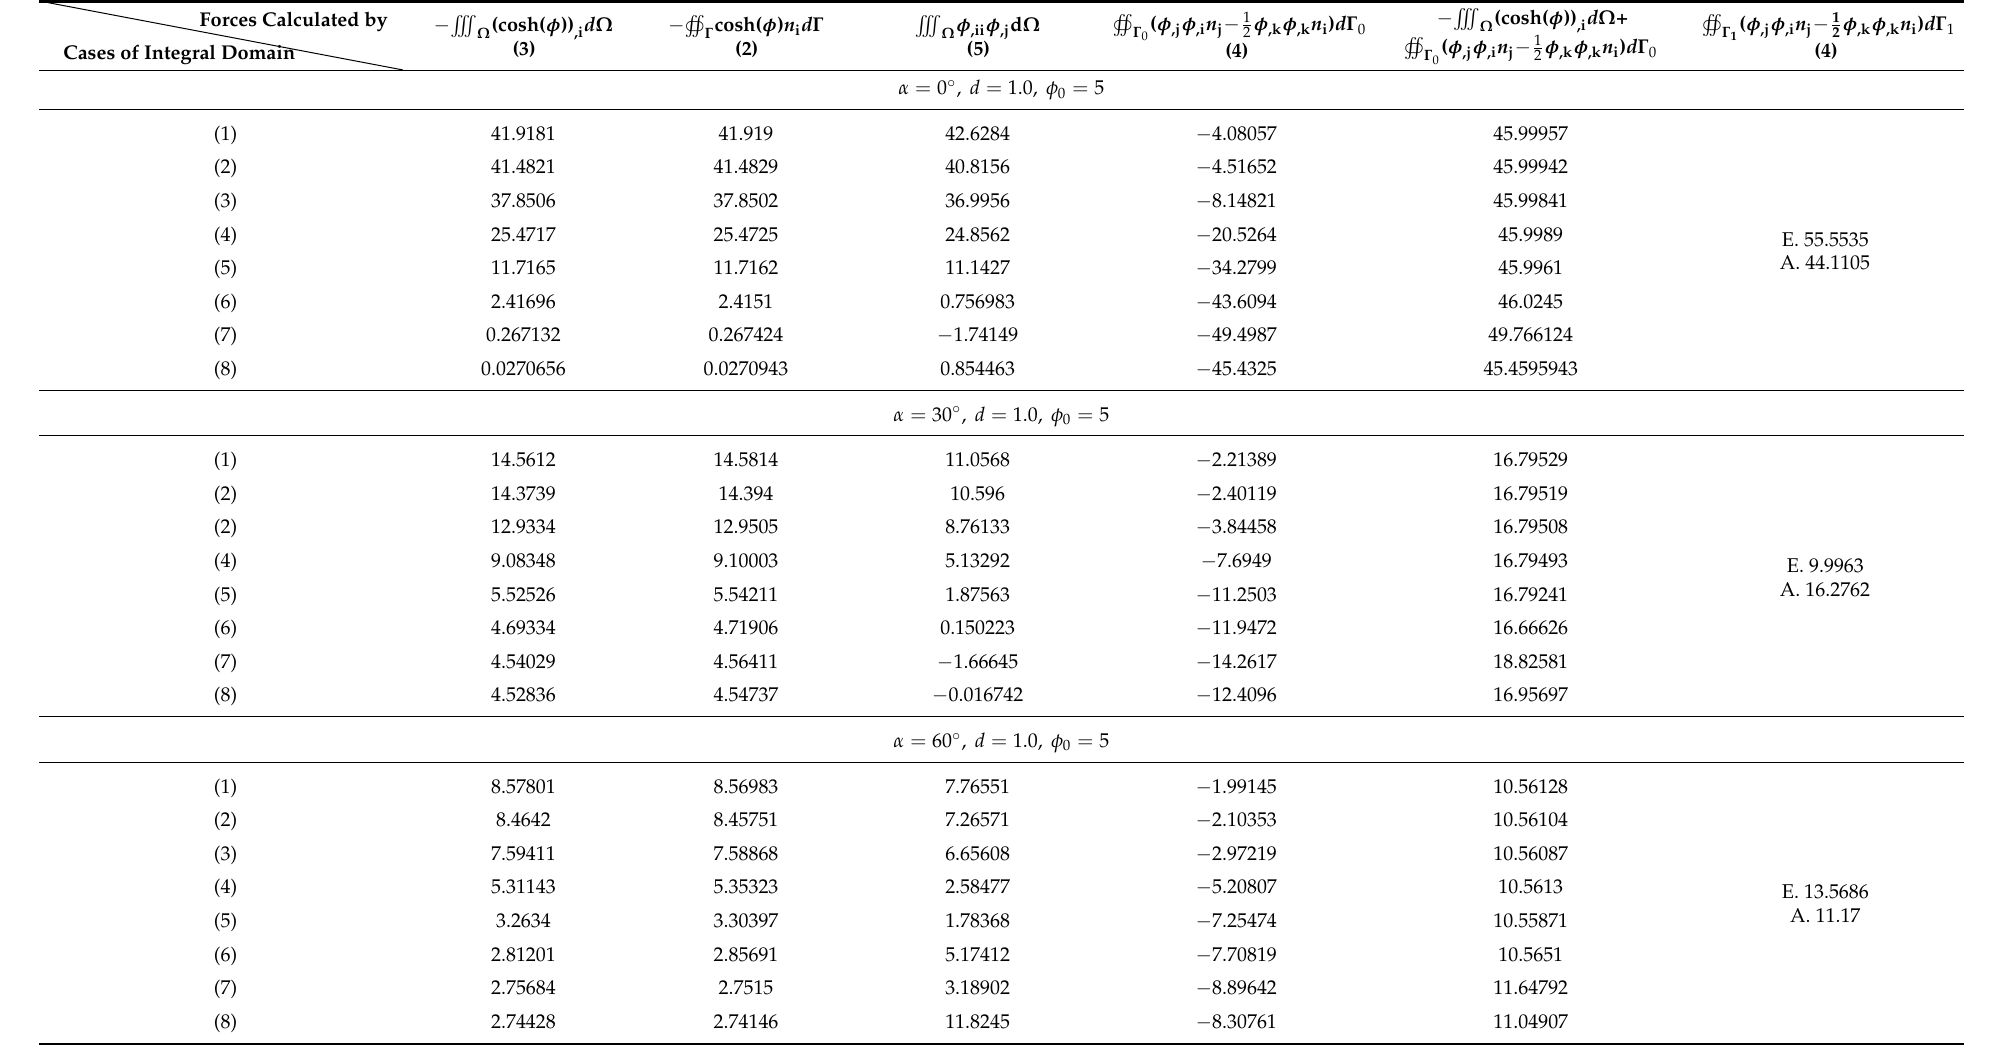
Table 3. Simulation results summary with various